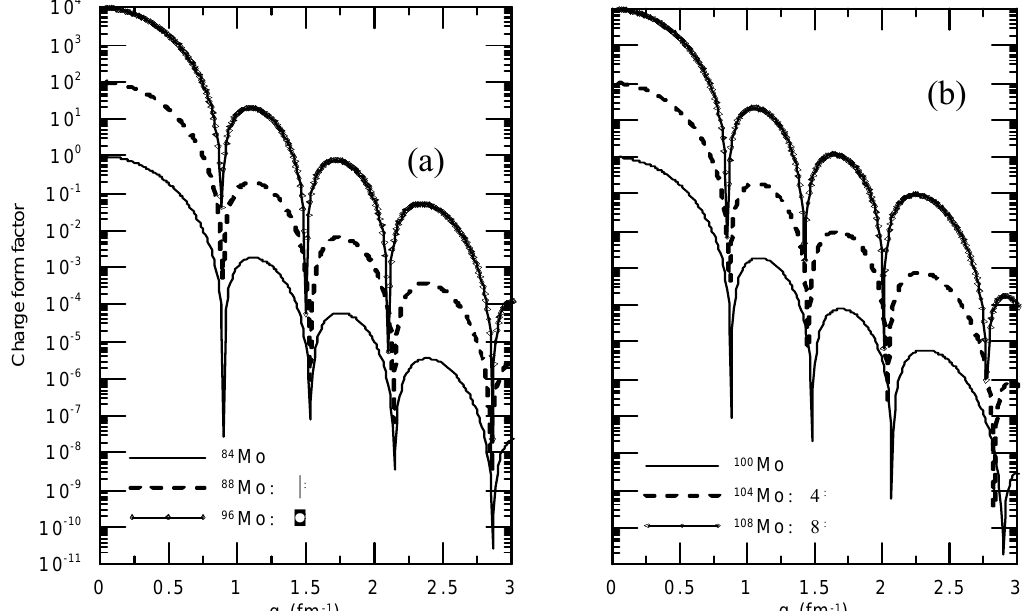
Fig. 8: The charge forms factor for 84-108 Mo isotopes versus momentum transfer q (fm -1 ) using Skxs25 Skyrme parameterization.